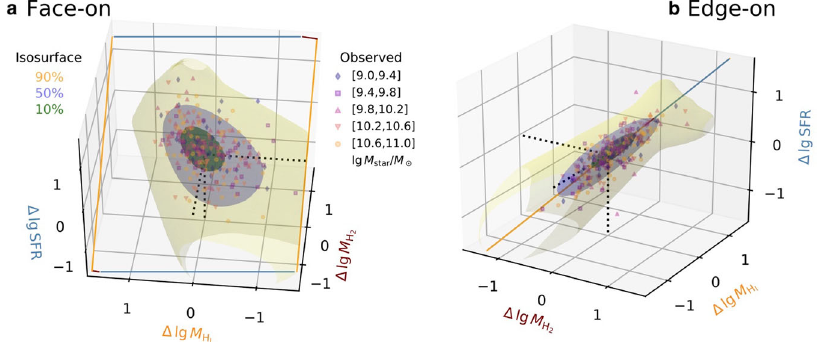
Fig. 2 Star-forming plane. a Face-on and b edge-on view of the star-forming plane. The star-forming plane refers to the largely two-dimensional distribution of star formation rates (SFRs), neutral and molecular gas masses relative to the peak position of the star forming, neutral gas, and molecular gas sequence for a given stellar mass. Markers indicate the measured SFRs and gas masses of xGASS/xCOLD GASS observations with marker shapes and colors corresponding to different stellar masses (see legend). Regions bounded by the green, blue, and yellow isosurfaces include 10, 50, and 90% of galaxies (without the zero component) according to the fi ducial model. Solid lines mark the intersections of the star-forming plane with the coordinate axes. The orientation of the star-forming plane is calculated via a principal component analysis based on the probability density within the 50% isosurface. The orientation of the star-forming plane is only weakly dependent on stellar mass.